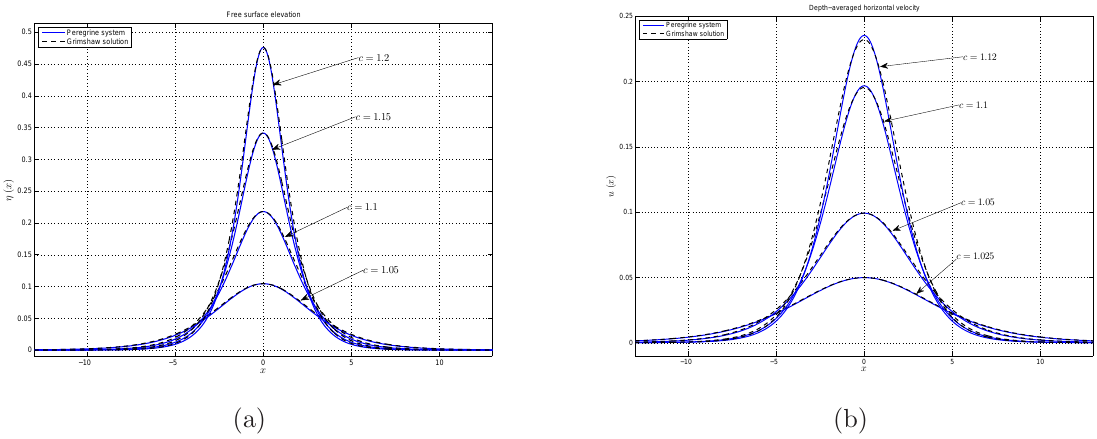
Fig. 6. Comparison of the numerical approximation of solitary wave solutions of Eq. (5) to Grimshaw’s third-order asymptotic approximation of solitary waves using the Euler equations for the full water wave problem. The upper panel shows the surface elevation, and the lower panel Figure 6. Comparison of the numerical approximation of solitary wave solutions √ shows the horizontal velocity at z = d 0 ( − 1 + 1 / 3 ) . of ( 3.1) to Grimshaw’s third-order asymptotic approximation of soli- tary waves using the Euler equations for the full water wave problem. The left panel shows the surface elevation, and the right panel shows the horizontal velocity at z = d ( 1 + 1 / 3) . 0 − p